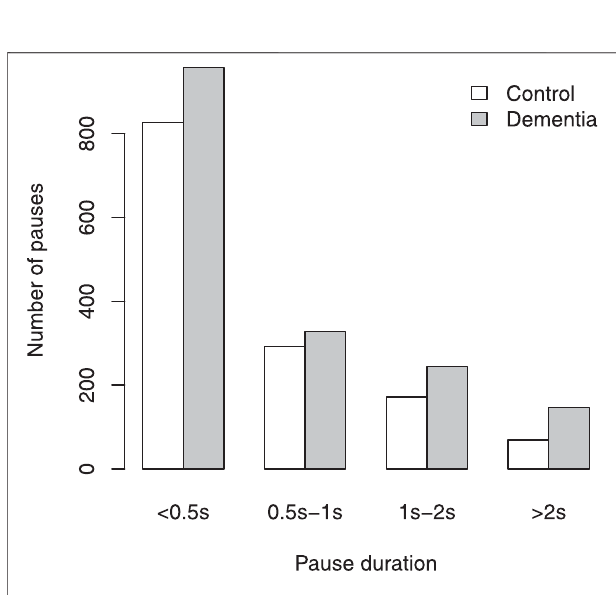
FIGURE 2 | Subjects with AD have more pauses (in all duration